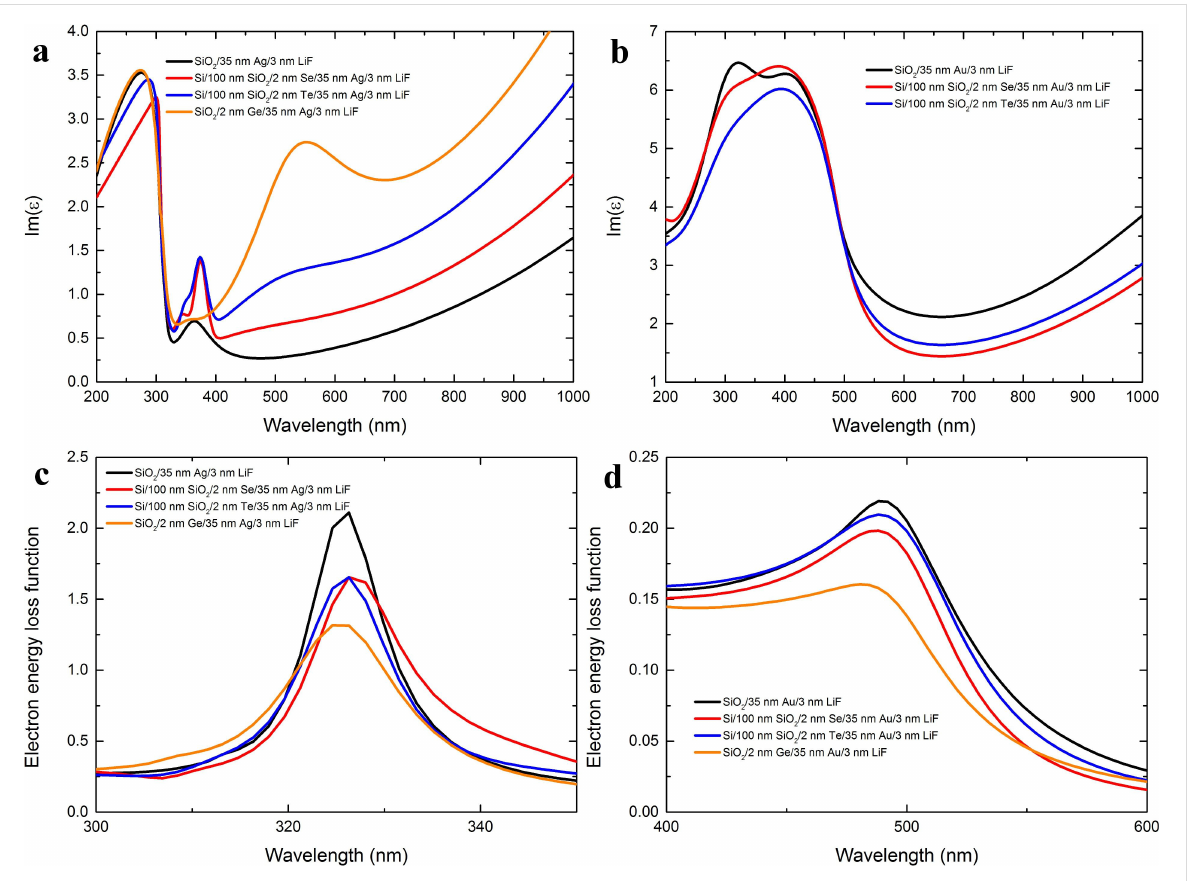
Figure 3: (a,b) Imaginary part of the permittivity for 35 nm-thick silver (a) and gold (b) layers deposited on Se (red curves) and Te (blue curves) inter- layers. (c,d) Electron energy loss function calculated using the permittivity values presented in a and b, respectively, for wavelengths in the vicinity of the metal plasma frequency. For comparison, the curves for layers deposited directly on glass substrates (black curves) as well as Ge-wetted layers (orange curves) are also provided